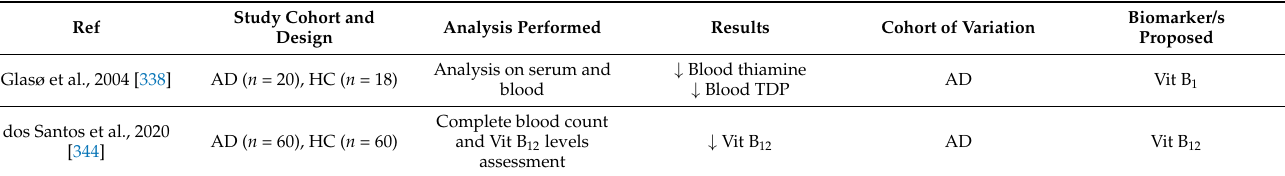
Table 3. Vitamin-based biomarkers for